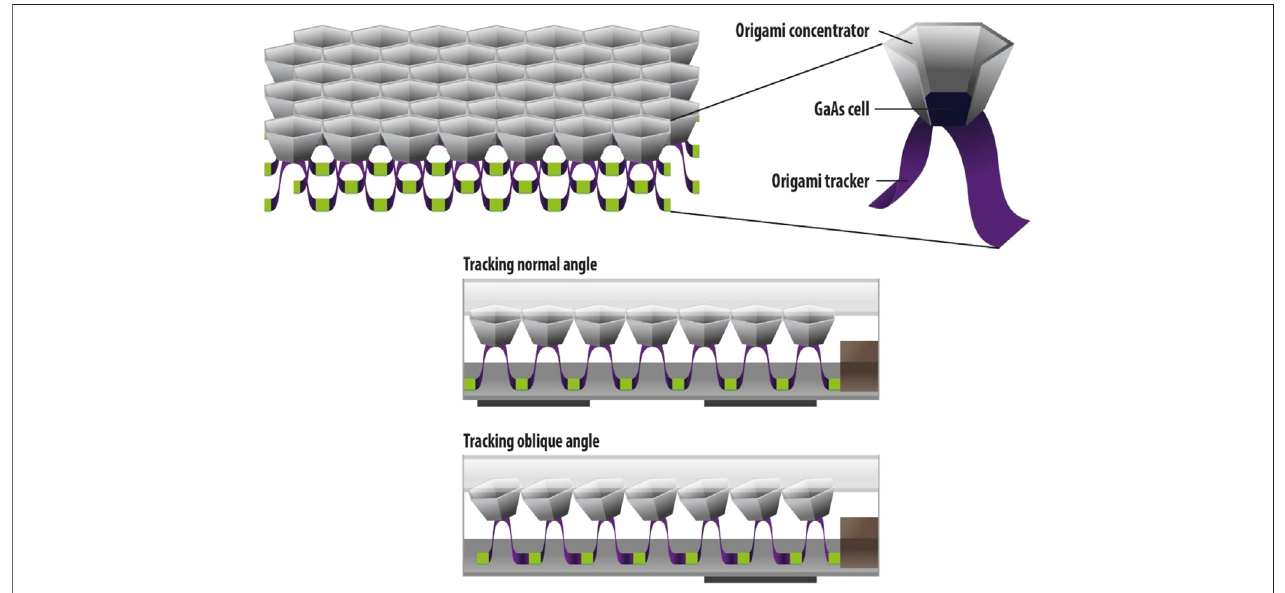
FIGURE 5 | A line-focus concentrator based on continuous rotation of a cylindrical lens focusing onto a “ strip ” of solar cells (Lee et al., 2019).